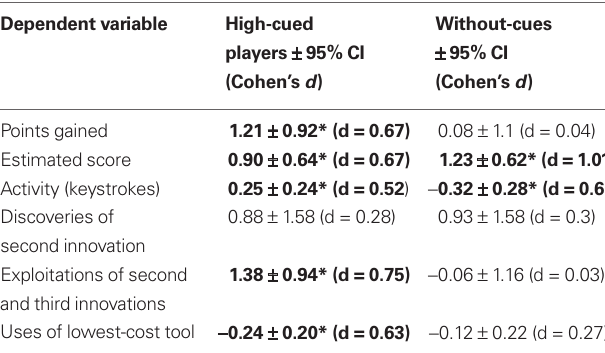
Table 1 | Comparison between participants exposed to high- performance cues, low-performance cues, or no cues a